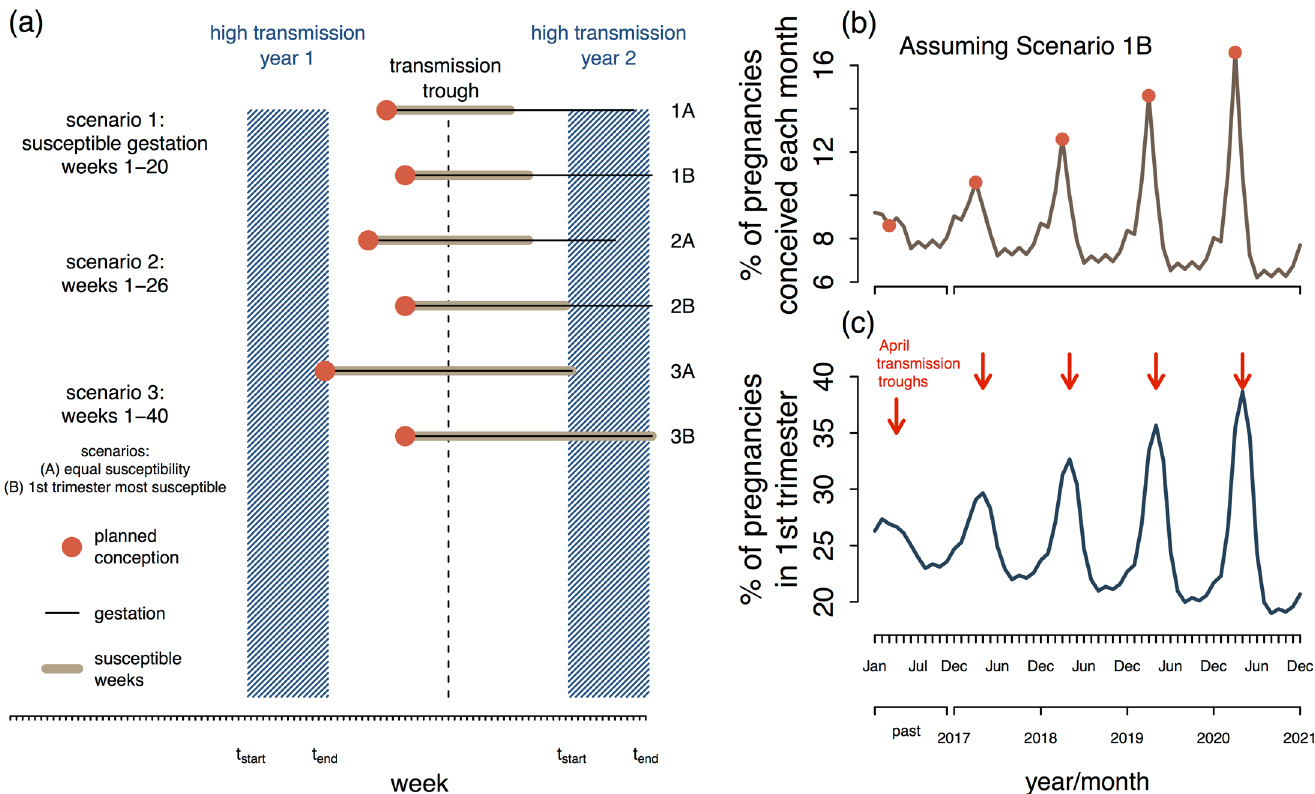
Fig 3. Planning pregnancy to take advantage of the low ZIKV transmission season. (a) Window of opportunity for conception based on the region- specific transmission season and the susceptible period of gestation. The high-transmission season is marked in blue, and the transmission trough is indicated by the dashed line. The ZIKV-susceptible gestation period is unknown, but preliminary data suggest that all three trimesters are susceptible; however, the first two trimesters are particularly vulnerable. The six scenarios depict the window of opportunity for conception under different susceptible gestation periods. Scenario 1 is susceptibility during gestation weeks 1 – 20, similar to other congenital infections. Scenario 2 is susceptibility during weeks 1 – 26, i.e., the first and second trimester. Scenario 3 is susceptibility during weeks 1 – 40, all three trimesters. The A and B variants of each scenario indicate whether there is uniform susceptibility across the susceptible gestation period or if the first trimester is particularly vulnerable. Policy could encourage planned conception such that the susceptible gestation period is aligned with the transmission trough. This policy would minimize the risk of maternal exposure when the fetus is most vulnerable. The window of opportunity for conception varies depending on when (in the calendar year) the high-transmission season occurs. (b) Theoretical trajectory of conception in Puerto Rico if conception were seasonally planned. The percent indicates the monthly value based on pregnancies initiated that year. The transmission trough was assumed to be in April (based on the data in Fig 1A and 1C). Gestation weeks 1 – 20 were assumed to be susceptible, with the first trimester being particularly vulnerable and given highest priority for protection. Conception was therefore encouraged in March, which had the effect of shifting and amplifying the birth pulse. The projection assumes that, each year, planned conception results in 3% of annual births that would have occurred in Jan., May., Jun., Jul., Aug., Sep., Oct., Nov., or Dec. being redistributed to Feb (0.5%), Mar (2%), and Apr (0.5%). (c) The seasonal distribution of pregnancies in the first trimester based on the conception trajectory in b. S5 Data provides R-code used to produce Fig 3B and 3C. S6 Data and S7 Data contain the time series plotted in Fig 3B and 3C,